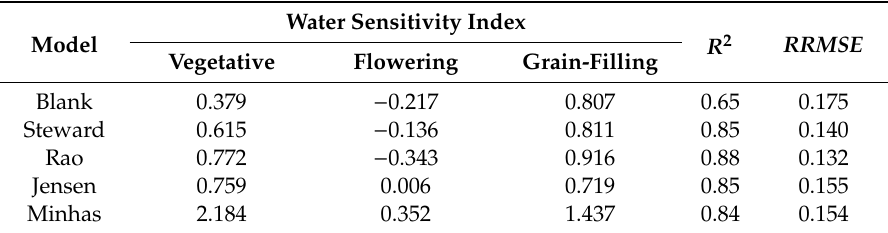
Table 9. The calibration results of seed vigor water sensitivity indices at the vegetative, flowering, and grain-filling stages for di ff erent models, calibrated using 12 irrigation treatments in 2018 and 2019. R 2 , determination coe ffi cients; RRMSE , relative root-mean-square